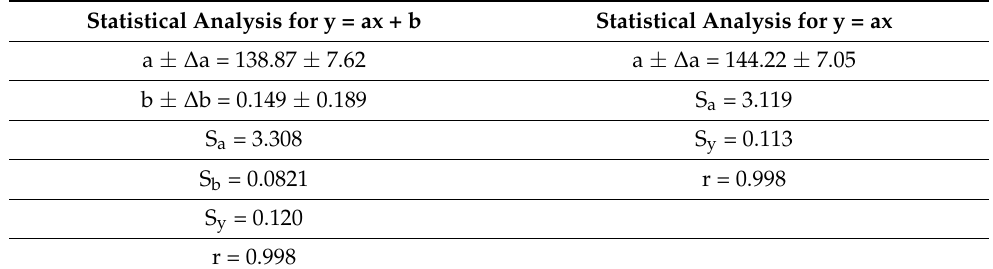
Table 2. Regression parameters for the stability-indicating HPLC method for RAM